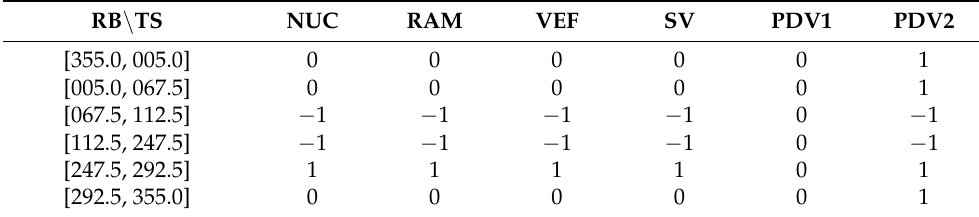
Figure 3. Encounter situation division (A, B, C, D, E, F represent the target ships): ( a ) Encounter situation division in sight of one another; ( b ) encounter situation division not in sight of one another. OS is a regular power-driven vessel (PDV). For a vessel being overtaken (A), the action value is 0. For an overtaken vessel (B), the action value is − 1. For a head-on vessel (C), the action value is 1. For a crossing vessel from starboard (D), the action value is 1. For a crossing vessel from the port side (E), the action value is 1. For the other types of vessels in Rule 18, the action value is 0. For an abeam vessel (F), OS should avoid altering course toward it. Based on these, the CAAM in sight of one another is shown in Table 1.